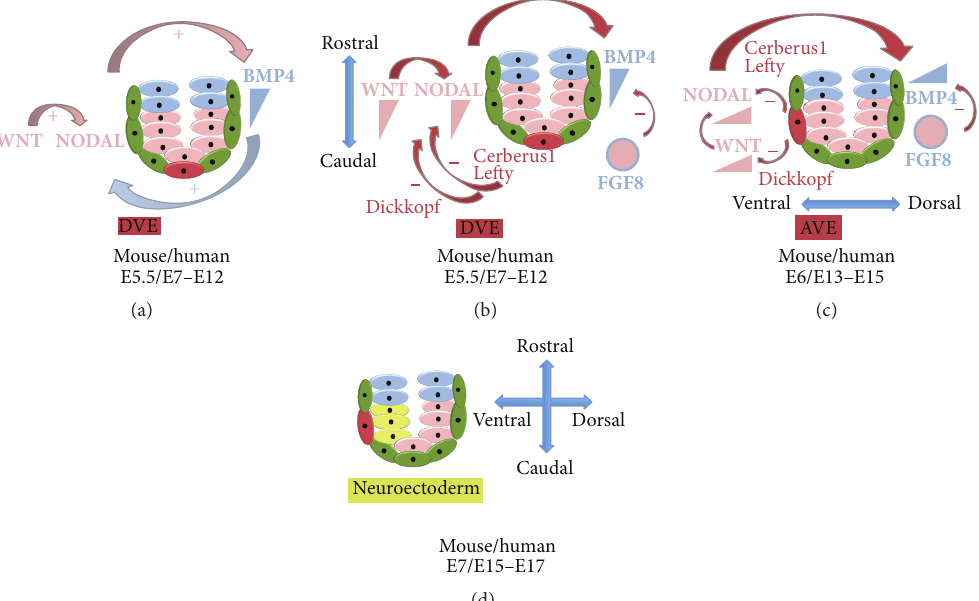
Figure 3: Molecular pathways in neural induction. (a) The epiblast (depicted in pink) expresses Nodal. The epiblast through Nodal stimulates (pink arrow) the expression of BMP4 (depicted in blue) in the extraembryonic ectoderm (blue cells). The extraembryonic ectoderm, by the action of BMP4, stimulates (blue arrow) the WNT (depicted in pink) pathway in the epiblast that in turn further activates (pink arrow) Nodal expression. Thus, there is a positive feedback loop between Nodal, BMP, and WNT. Colour scheme: arrows corresponds to the related tissue/morphogen. (b) The DVE (depicted in red) expresses Cerberus1 and Lefty (also depicted in red) to inhibit Nodal expression, therefore downregulating Nodal in its proximity. It also expresses Dickkopf (depicted in red), a protein that inhibits WNT3 signals close to the DVE. Downregulating Nodal and WNT also inhibits BMP4 expression close to the DVE. Thus, there is a gradient of Nodal, WNT, and BMP with a high expression rostrally and low expression caudally. FGF8 (pink and blue), expressed both in the epiblast (pink) and extraembryonic ectoderm (blue), also inhibits BMP4 contributing to the gradient. Colour scheme: arrows corresponds to the secreted inhibitory molecules/tissue source (DVE). They show the consequence of the negative feedback that creates the morphogen gradients in the R-C axis. (c) The DVE migrates into the AVE and the gradients are thus remodelled with low Nodal, WNT, and BMP expression ventrally and high dorsally. (d) Due to these gradients the neuroectoderm is formed at the ventral pole of the epiblast. Colour scheme: arrows corresponds to the secreted inhibitory molecules/tissue source (AVE). They show the consequence of the negative feedback that creates the morphogen gradients in the D-V axis. All timelines are given for mouse and human embryonic